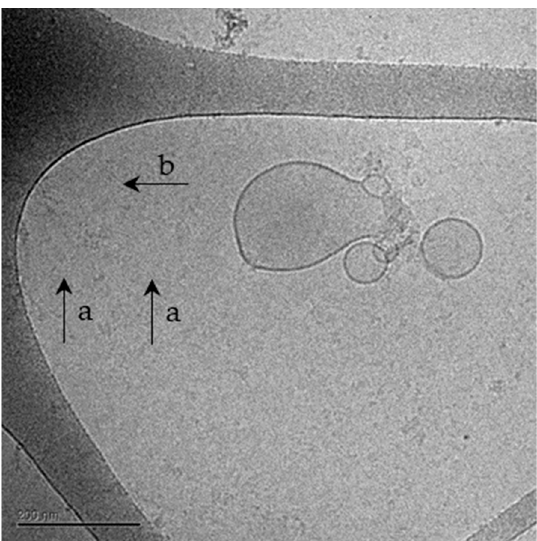
Figure 1. A representative image taken by Cryo-TEM of NPCE-derived EVs following electroporation. Cryo-TEM analysis of NPCE EVs after electroporation. Cryo-TEM analysis was performed to ensure EV’s membrane integrity. An image of the electroporated sample represents the morphological difference between normal, intact EVs ( a ), compared to damaged EVs ( b ).